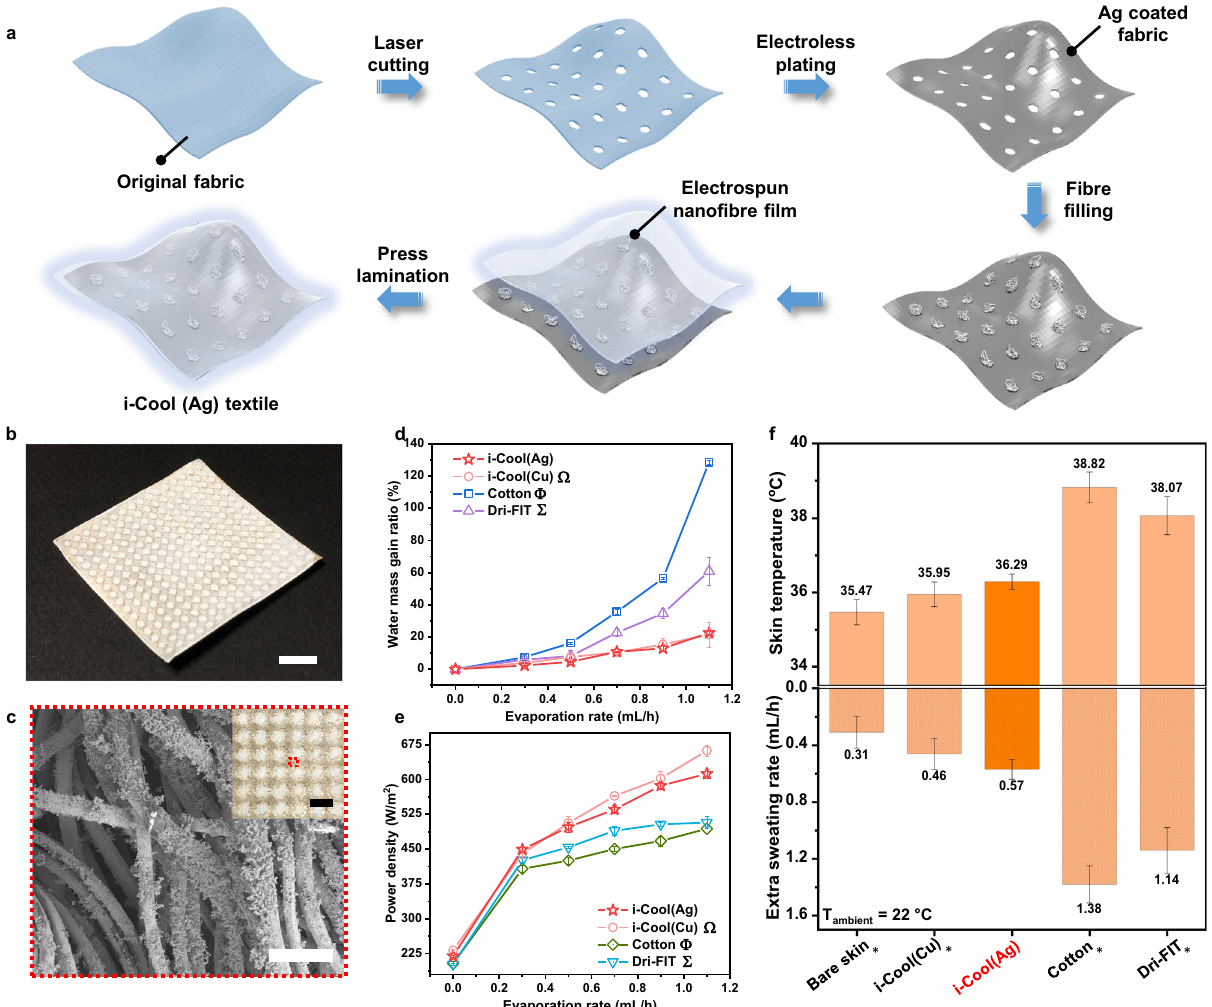
Fig. 5 Practical application feasibility demonstration of the i-Cool functional structure via i-Cool (Ag) textile. a , Illustration of the fabrication process of i-Cool (Ag) textile based on a commercially available fabric. b , Photograph of as-fabricated i-Cool (Ag) textile based on Dri-FIT as the substrate. Scale bar, 1 cm. c , SEM image showing the uniform and conformal Ag coating on the PET fi bers of the fabric substrate. Scale bar, 50 µ m. The inset shows the photograph of i-Cool (Ag) viewing from its bottom. Scale bar, 4 mm. d , Measured water mass gain ratio of i-Cool (Ag) and other textiles at different evaporation rate in the steady-state evaporation test. Omega symbol, Statistical signi fi cance between the i-Cool (Ag) and i-Cool (Cu), Welch ’ s t -test p < 0.1 at 0.3 mL/h and 0.5 mL/h, no statistical signi fi cance for others. Phi symbol, Statistical signi fi cance between the i-Cool (Ag) and cotton, Welch ’ s test p < 0.05 at 0.3 mL/h, p < 0.001 for others. Sigma symbol, Statistical signi fi cance between the i-Cool (Ag) and Dri-FIT, Welch ’ s test shows no statistical signi fi cance at 0.5 mL/h, p < 0.05 at 0.7 mL/h, 1.1 mL/h, p < 0.01 for others. e , Measured power density of i-Cool (Ag) and other textiles at different evaporation rate in the steady-state evaporation test. Omega symbol, Statistical signi fi cance between the i-Cool (Ag) and i-Cool (Cu), Welch ’ s t -test p < 0.01 at 0 mL/h, 1.1 mL/h, p < 0.05 at 0.7 mL/h, no statistical signi fi cance for others. Phi symbol, Statistical signi fi cance between the i-Cool (Ag) and cotton, Welch ’ s test p < 0.001 at 0.7 mL/h and 0.9 mL/h, p < 0.01 for others. Sigma symbol, Statistical signi fi cance between the i-Cool (Ag) and Dri-FIT, Welch ’ s test p < 0.05 at 0.5 mL/h, p < 0.01 at 0.3 mL/h and 0.7 mL/h, p < 0.001 for others. f , Measured skin temperature and sweating rate of the i-Cool (Ag) textile on the arti fi cial sweating skin platform with feedback control loop. Asterisk, Statistical signi fi cance of skin temperature and sweating rate between the i-Cool (Ag) and other textiles, Welch ’ s t -test p < 0.001. All the error bars represent standard deviation of measured